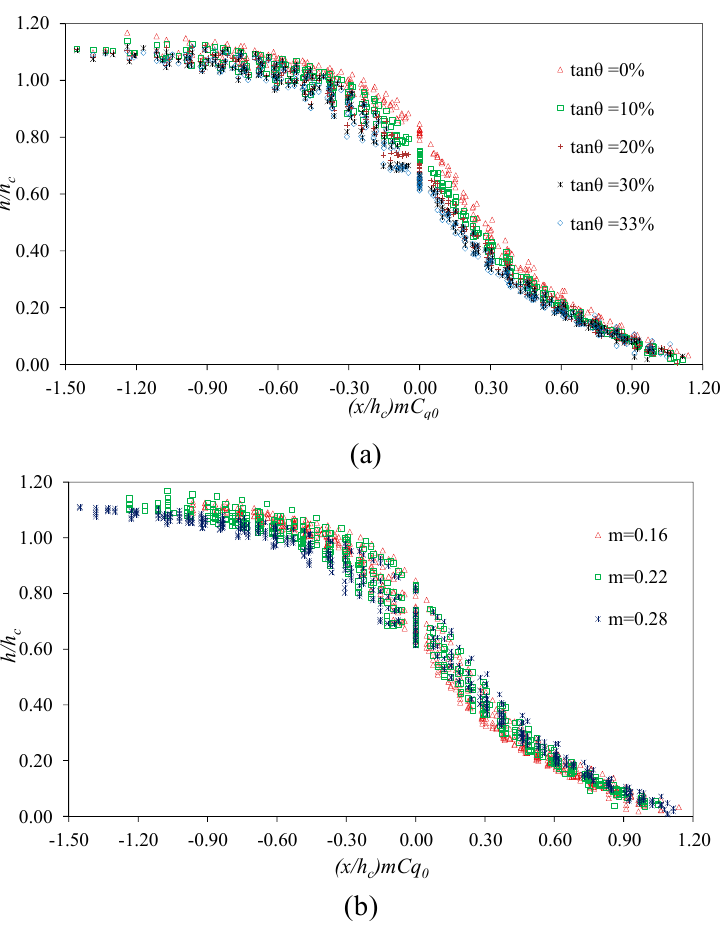
Figure 5. ( a ) Dimensionless flow depth, h/h c , as a function of the slope; ( b ) dimensionless values as a function of the void ratio.